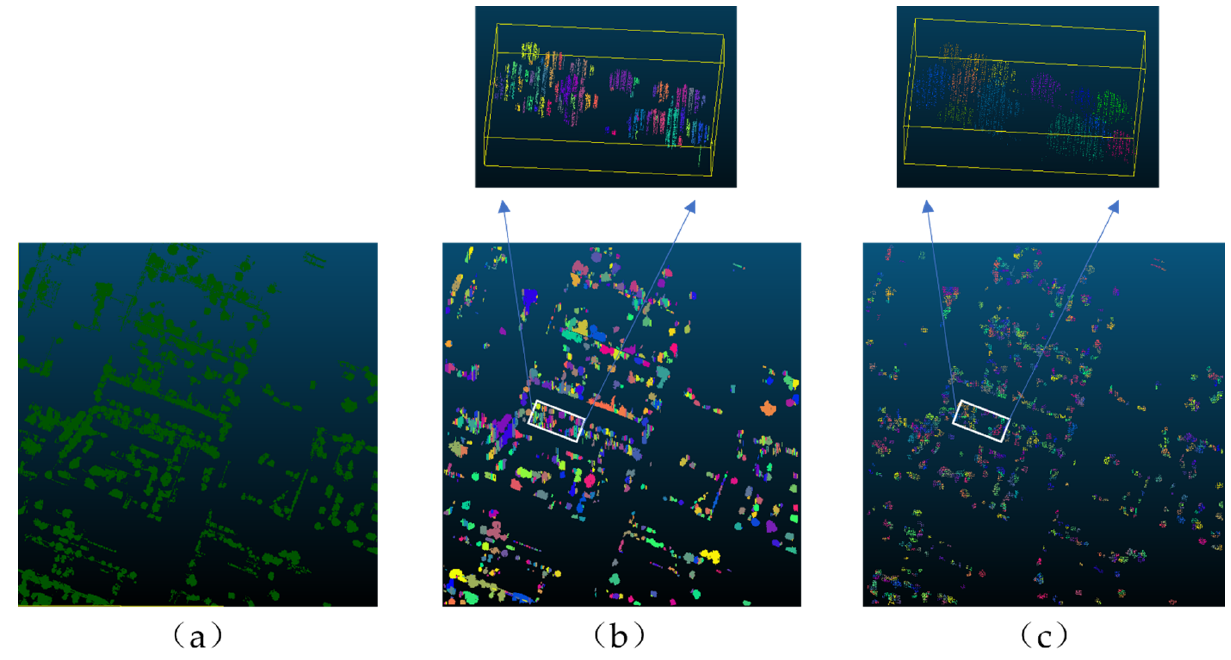
Table 8. Single-wood segmentation accuracy evaluation.